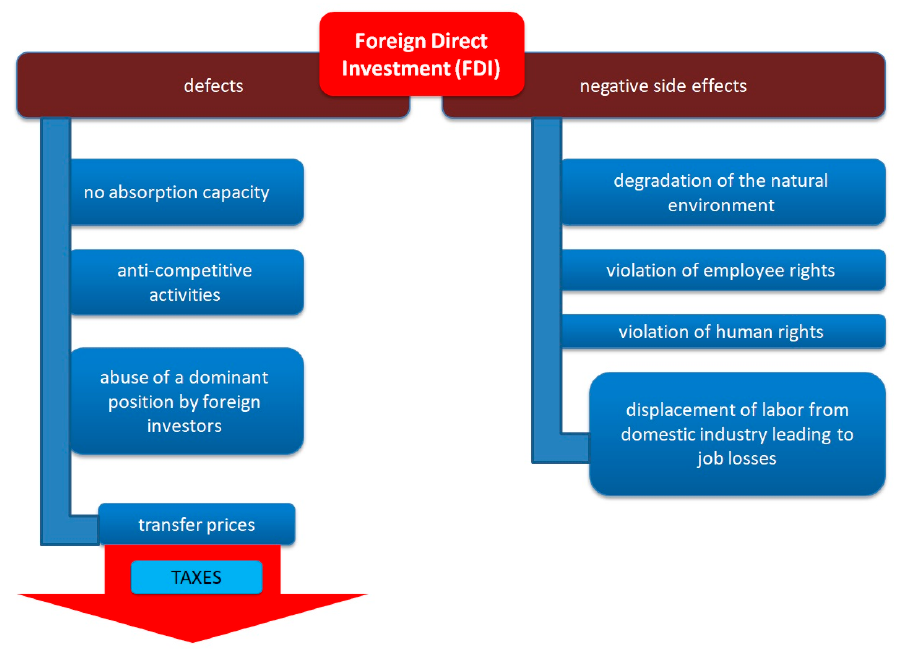
Figure 21. Disadvantages and negative side effects of FDI (Foreign Direct Investment). Source: own study.